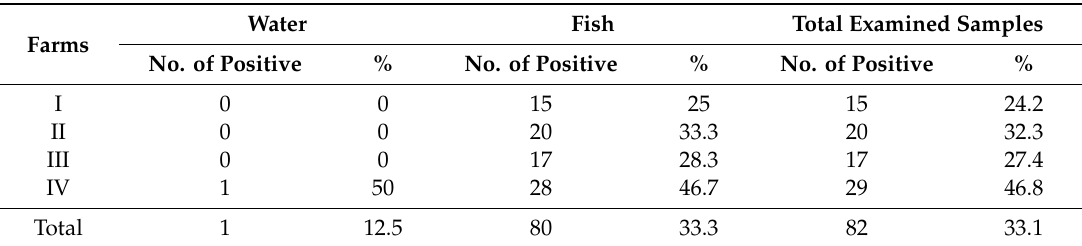
Table 4. Total prevalence of motile Aeromonads recovered from water and fish samples throughout the study period in the examined farms.